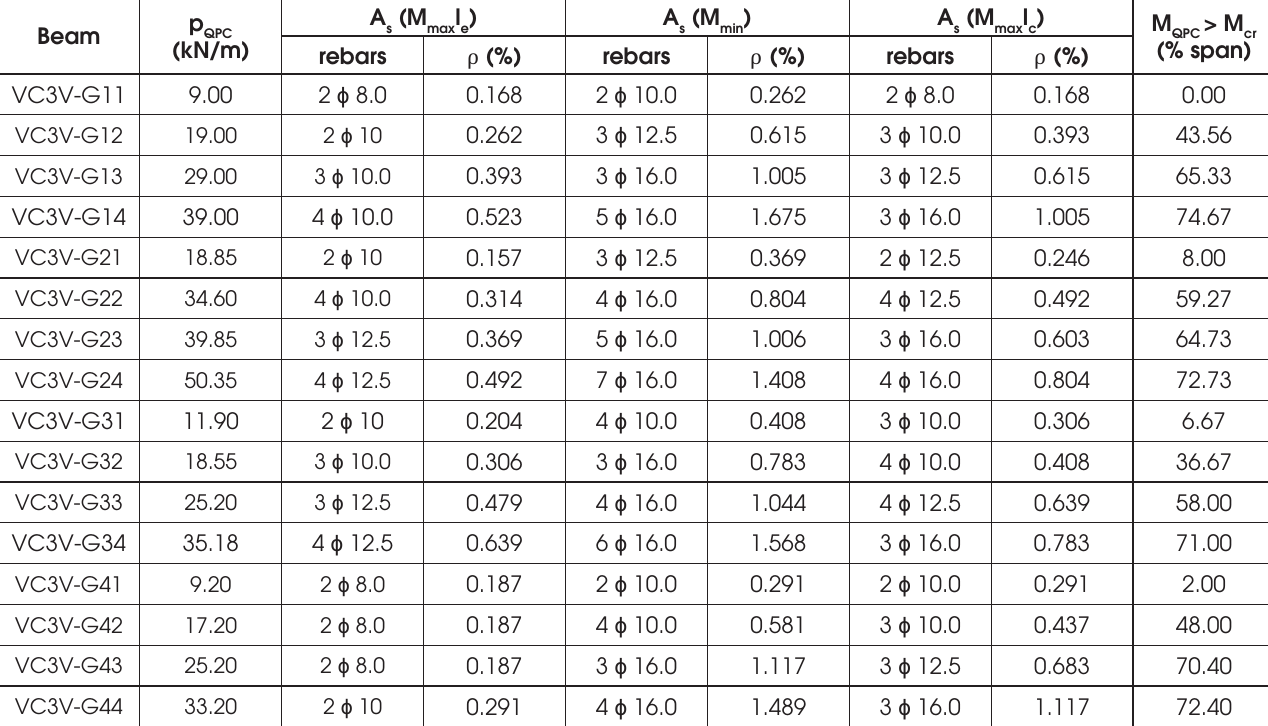
Details of load and longitudinal reinforcement for the three-span beams Beam